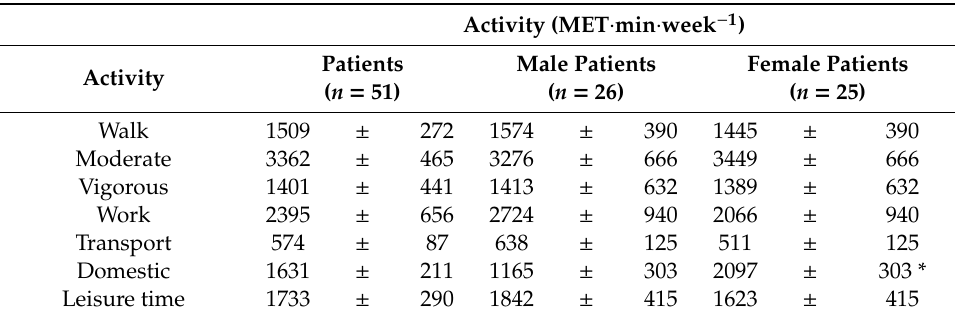
Table 6. Physical Activity categories adjusted by